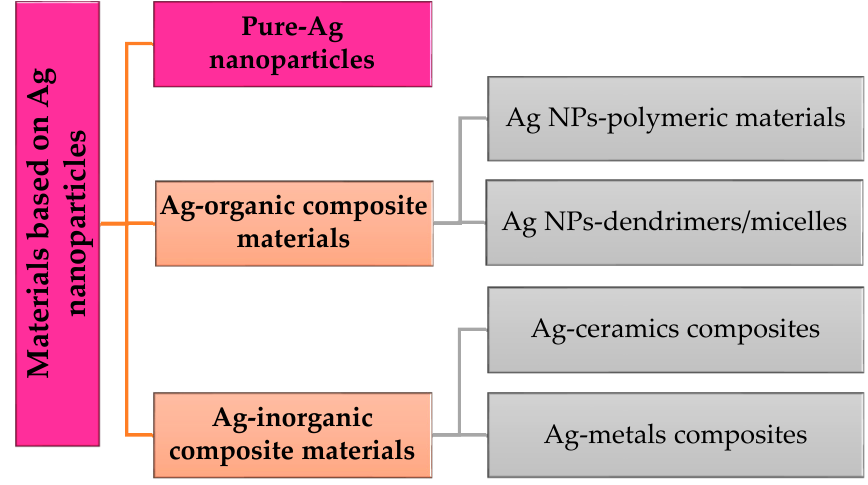
Figure 2. Top-down methods versus bottom-up methods from a nanoparticles perspective.